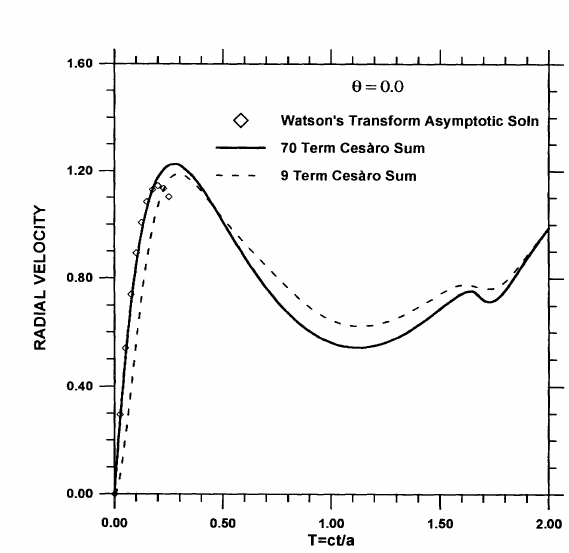
FIGURE 11 Comparison ofthe Cesaro sum represen tations of shell radial velocity due to a step incident wave to the Watson's transformation